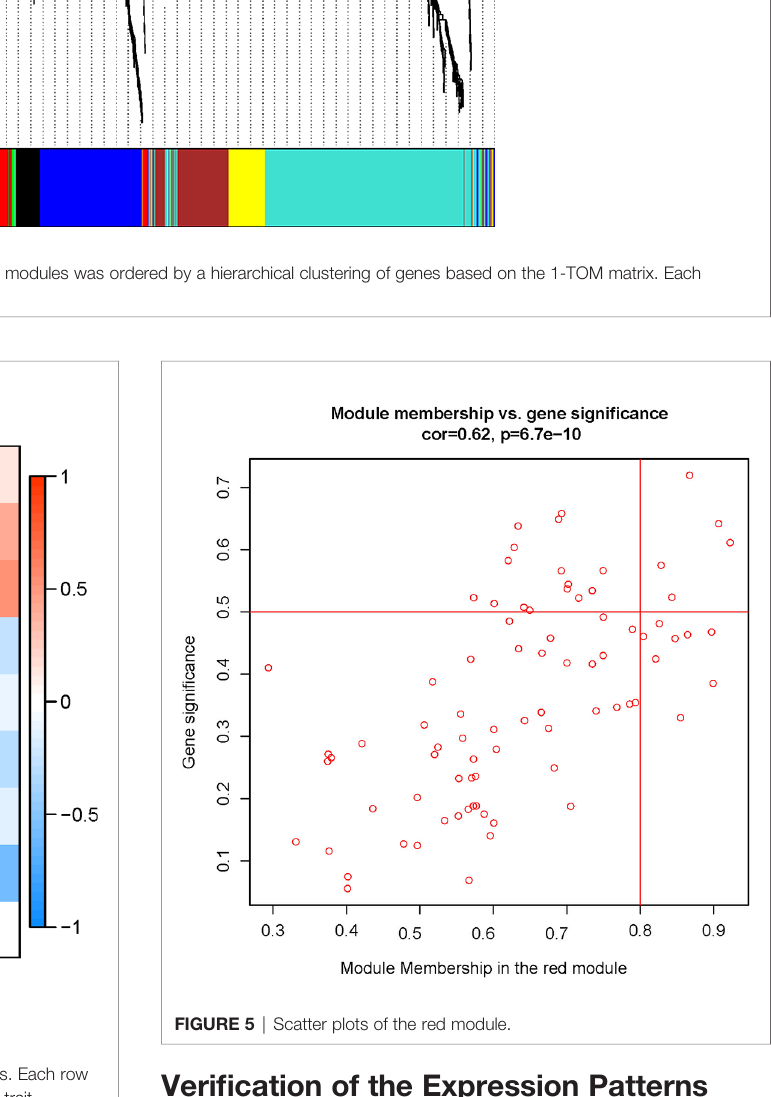
FIGURE 4 | Relationships between the module and clinical traits. Each row represents a color module and column corresponds to a clinical trait (chemotherapy-sensitive or chemotherapy-resistant). Each cell contains the corresponding correlation and p- value. network through the DMNC algorithm of CytoHubba plugin were shown in Figure 7 . According to the DMNC scores, the top ten highest-scored genes, including TGFBI, NID, LEPREL2, COL11A1, CYR61 , PCOLCE , IGFBP7 , COL4A2 , CSPG2 , and VTN , were regarded as hub genes.